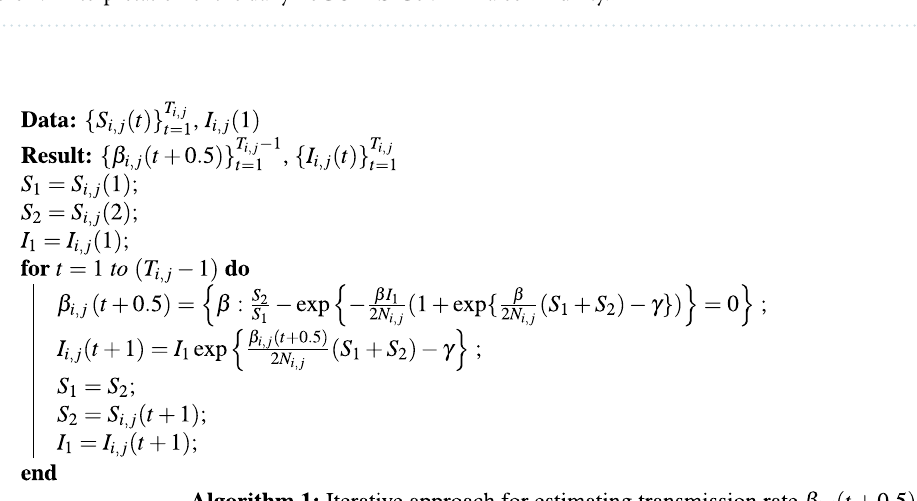
Table 2. Interpretation of the daily PoC SARS-CoV-2 in a